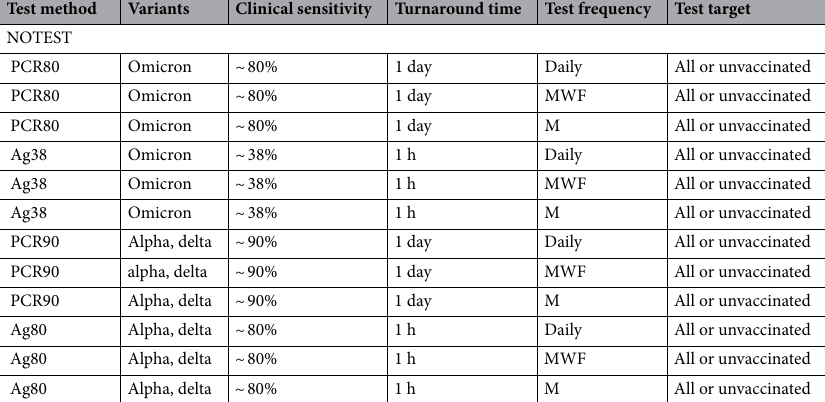
Table 1. Sensitivity and Specificity of simulated SARS-CoV-2 testing